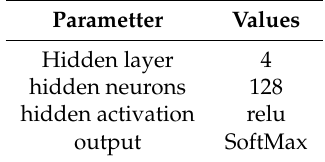
Table 1. Neural network